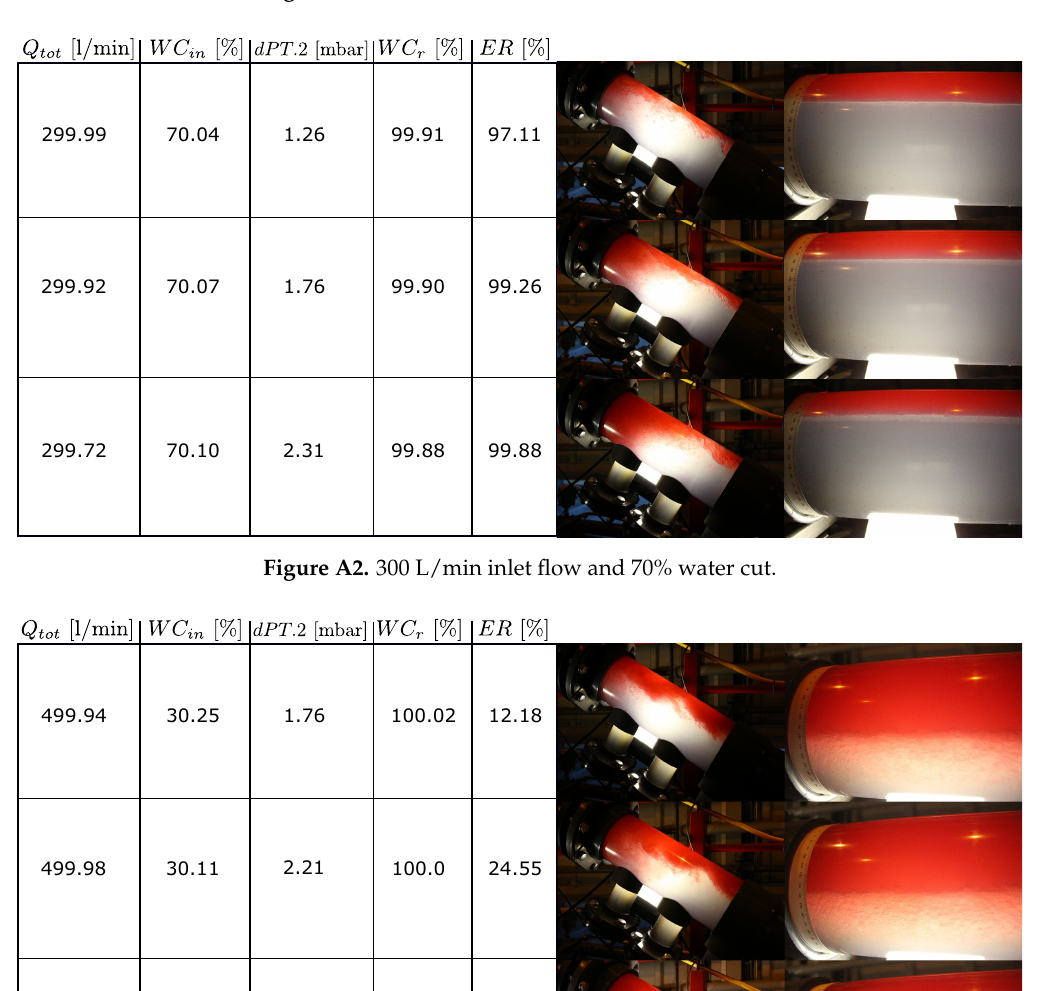
Figure A1. 300 L/min inlet flow and 30% water cut.